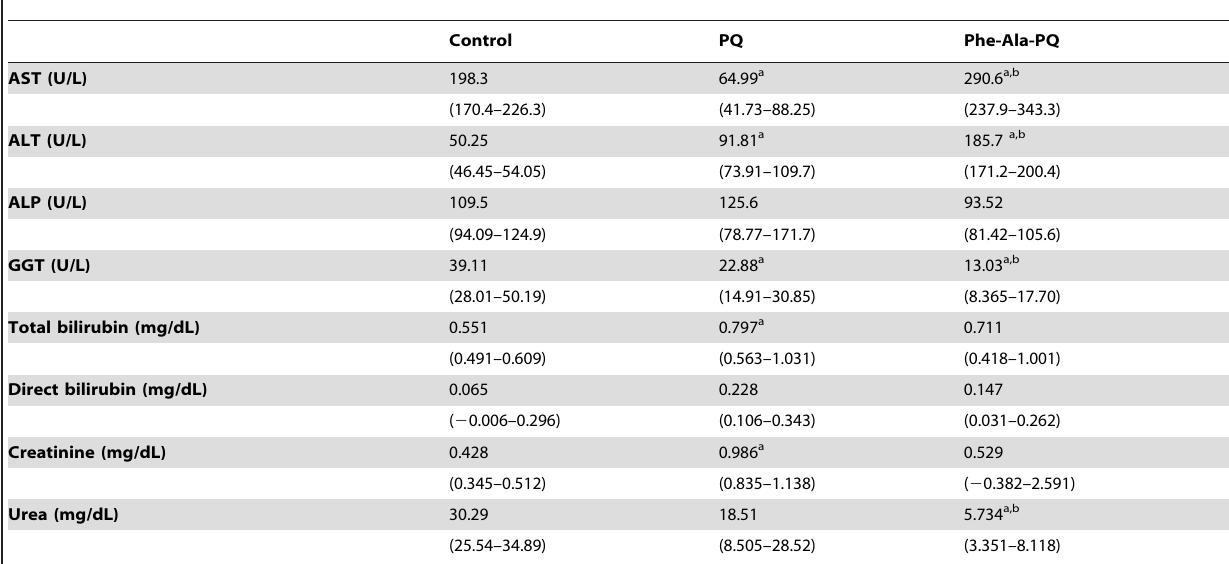
Table 4. Biochemical analysis of serum of rats treated with multiple doses of Phe-Ala-PQ or PQ (mean 6 CI 95).